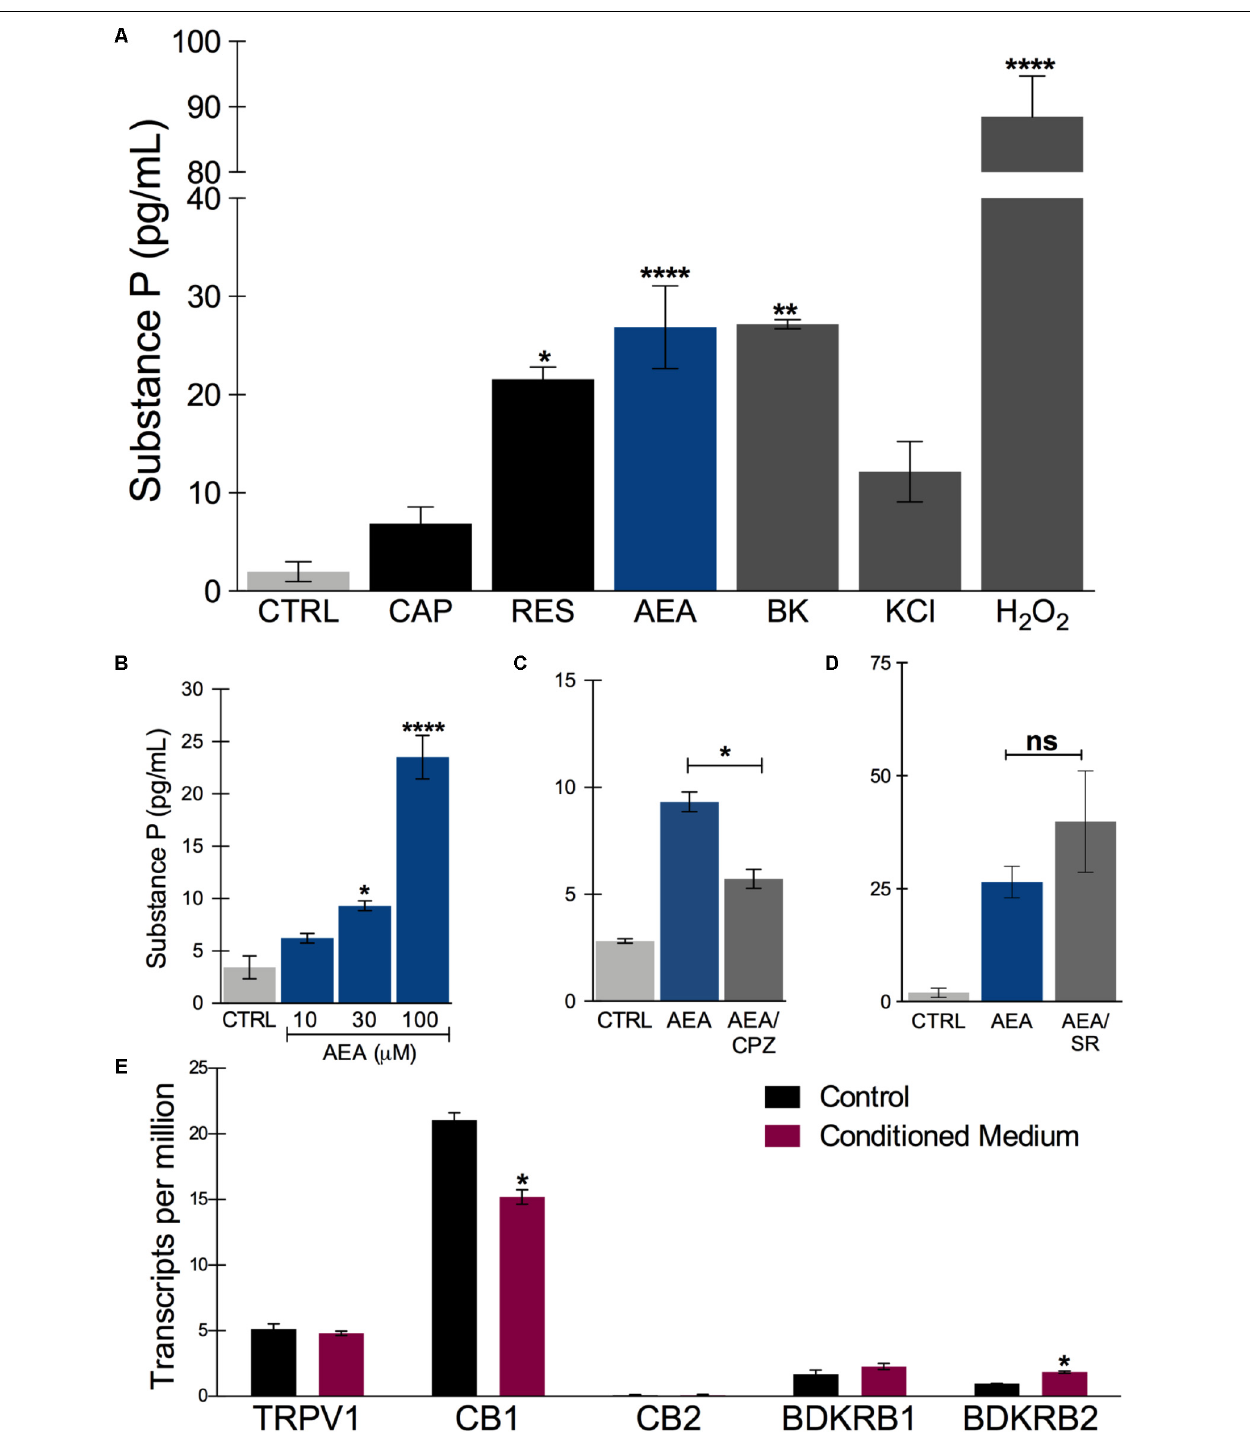
FIGURE 6 | Substance P release after in vitro treatment with nociceptive agents. (A) Substance P release measured in the supernatant of sensory neurons culture after incubating for 45 min at 37 ◦ C in the presence of ligands. CAP: capsaicin (300 nM); RES, resiniferatoxin (300 nM); AEA, anandamide (100 µ M, unless stated otherwise); BK, bradykinin (20 nM); KCl, high potassium solution (70 mM) and H 2 O 2 (0.25%). (B) Concentration-dependent effect of anandamide in substance P release. (C) Anandamide effect (30 µ M) is partially inhibited by capsazepine (CPZ) (30 µ M). (D) Anandamide effect (100 µ M) is not significantly changed by rimonabant (SR) (10 µ M). (E) Transcript levels of the putative receptors involved in substance P release by the tested agonists. TRPV1, transient receptor potential vanilloid 1; CB1, cannabinoid receptor 1; CB2, cannabinoid receptor 2; BDKRD1, bradykinin receptor 1; BDKRD2, bradykinin receptor 2. One way ANOVA followed by Tukey’s multiple comparison test, ∗ p < 0.05, ∗∗ p < 0.01, and ∗∗∗∗ p < 0.0001. n = 2–3 individual experiments from three separate